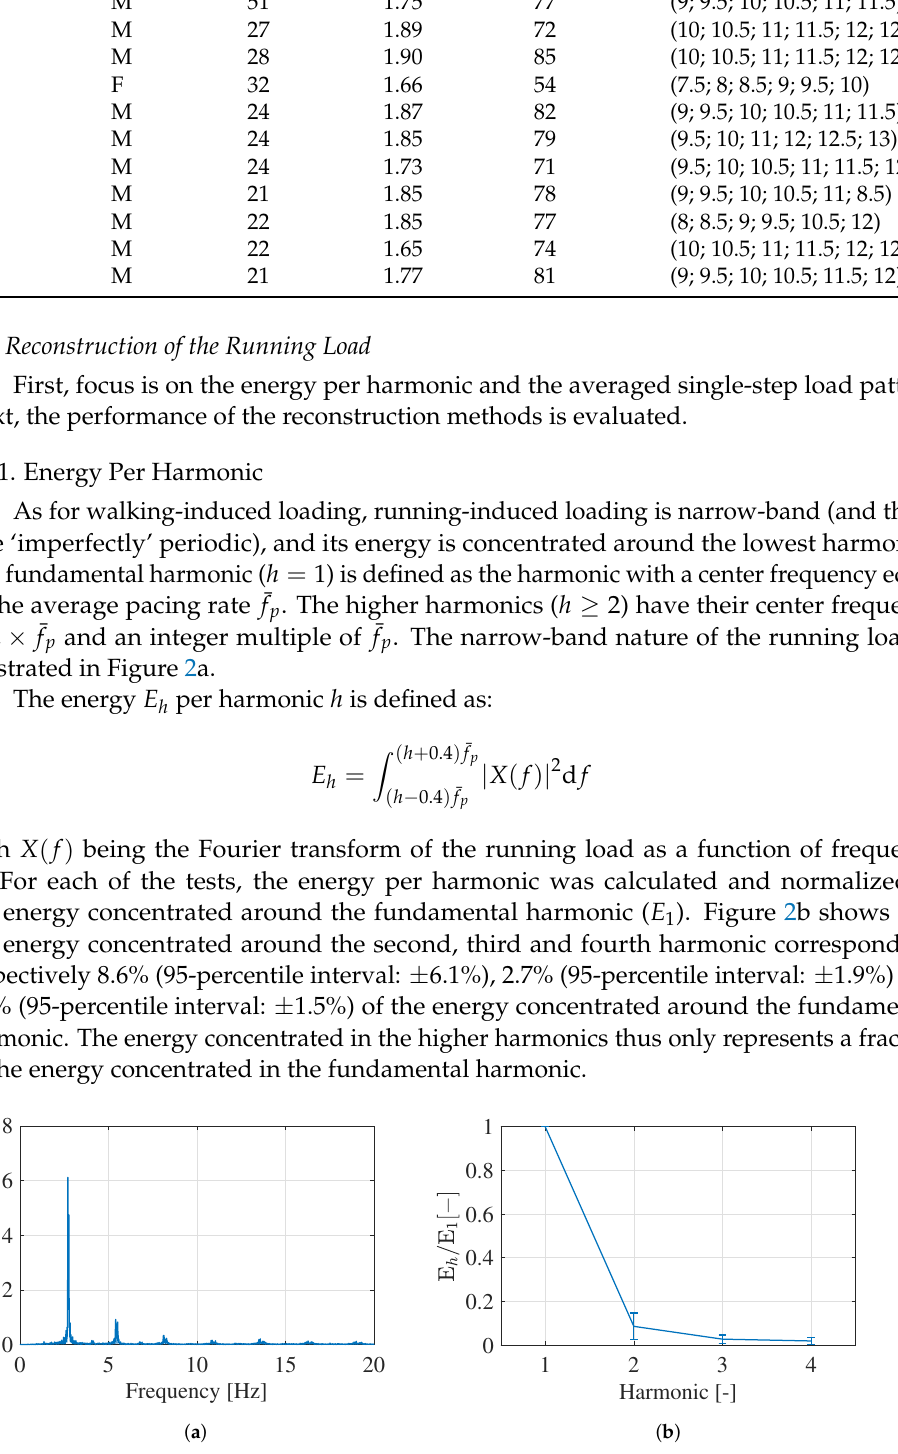
Figure 2. ( a ) The amplitude spectrum of the load induced by participant 1 during test 1; ( b ) The energy per harmonic ( E h ), normalized to E 1 , for all laboratory tests, the error bar represents the 95-percentile of the